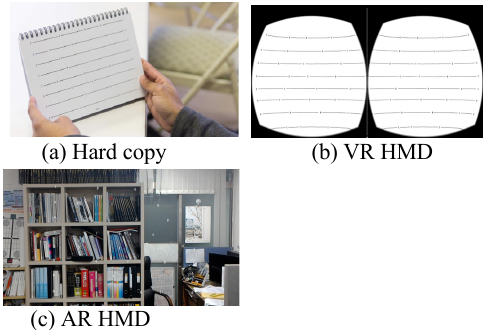
Figure 6. K-D chart for each